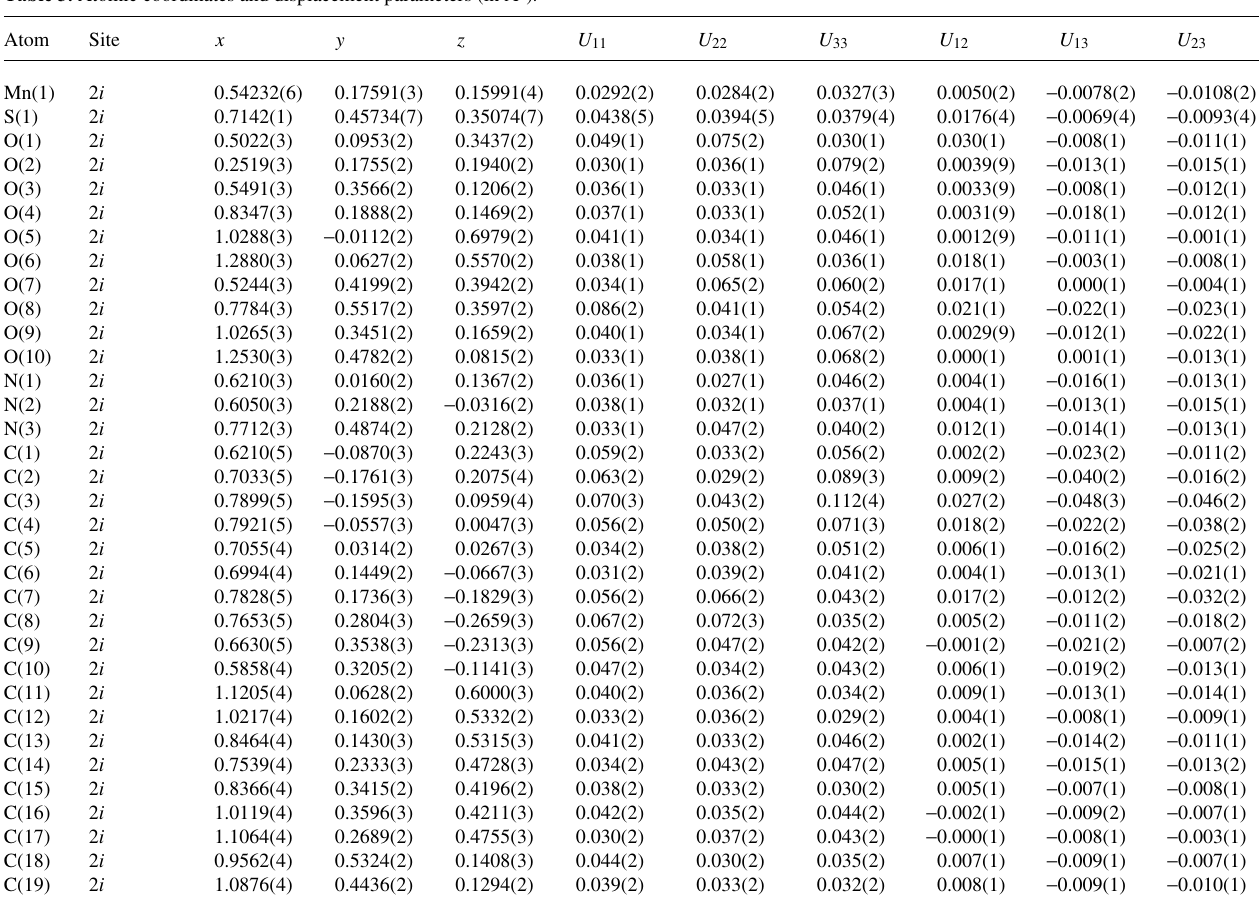
Table 3. Atomic coordinates and displacement parameters (in Å 2 )